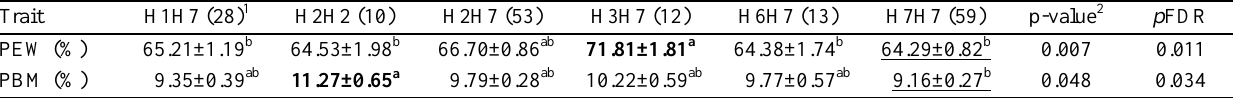
PEW, percentage of eviscerated weight; PBM, percentage of breast muscle; p FDR, the positive false discovery rate. 1 The numbers in parentheses represent the number of diplotypes. 2 Probability of the F-test for Type III SS. Values represent least squares means plus or minus standard error. Superscripts within a trait represent a difference among breeds at p<0.05 (Tukey’s test). Bolded values represent the diplotypes with the greatest values. Underlined values represent the diplotypes with the smallest values.